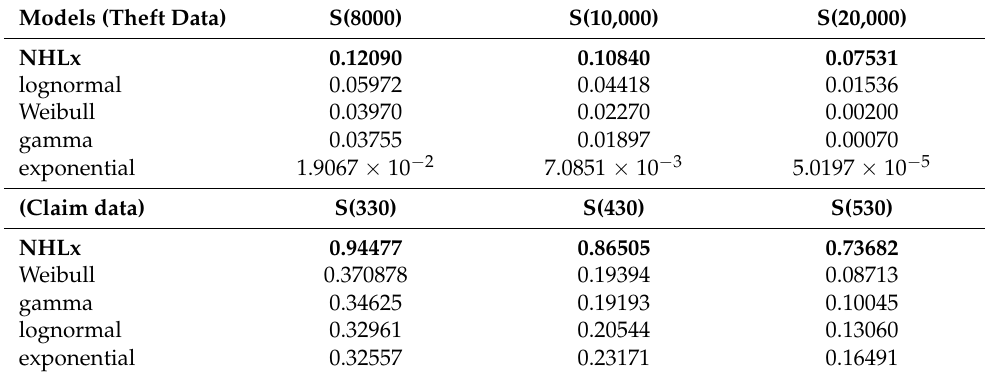
Table 2. Estimation of the tail probabilities of various distributions for the considered data sets.